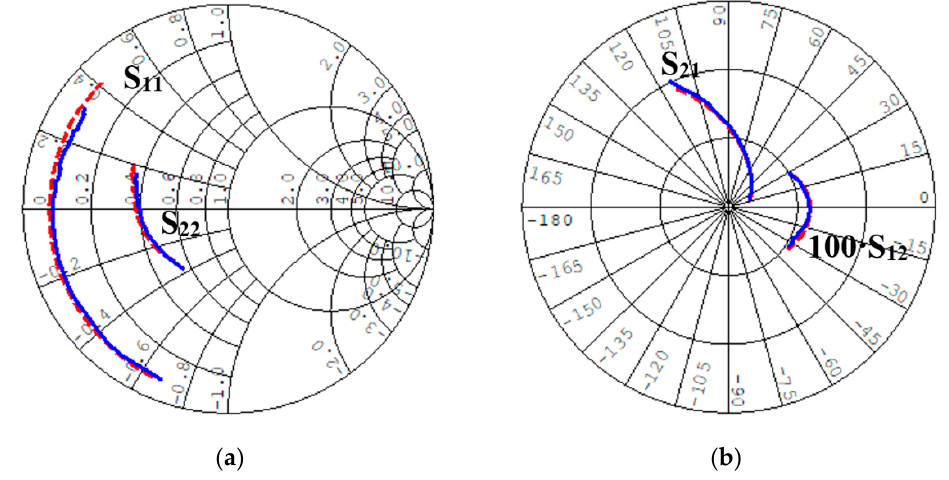
Figure 14. Scattering parameters measured by NRL with transmission lines (red dashed line) and UniME (blue solid line) for a HEMT with gate width of 10 × 60 μ m (3.5–26 GHz). ( a ) S 11 and S 22 , ( b ) S 21 and 100 · S 12 . V DS = 2 V and I DS = 120 mA.